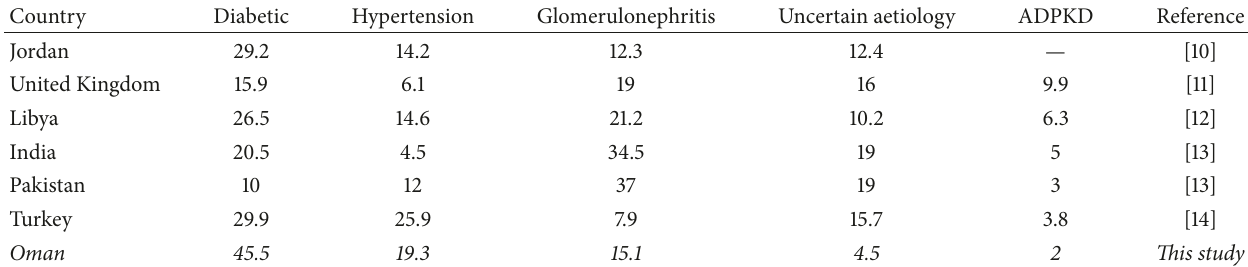
Table 3: Primary causes of ESKD in Oman and other